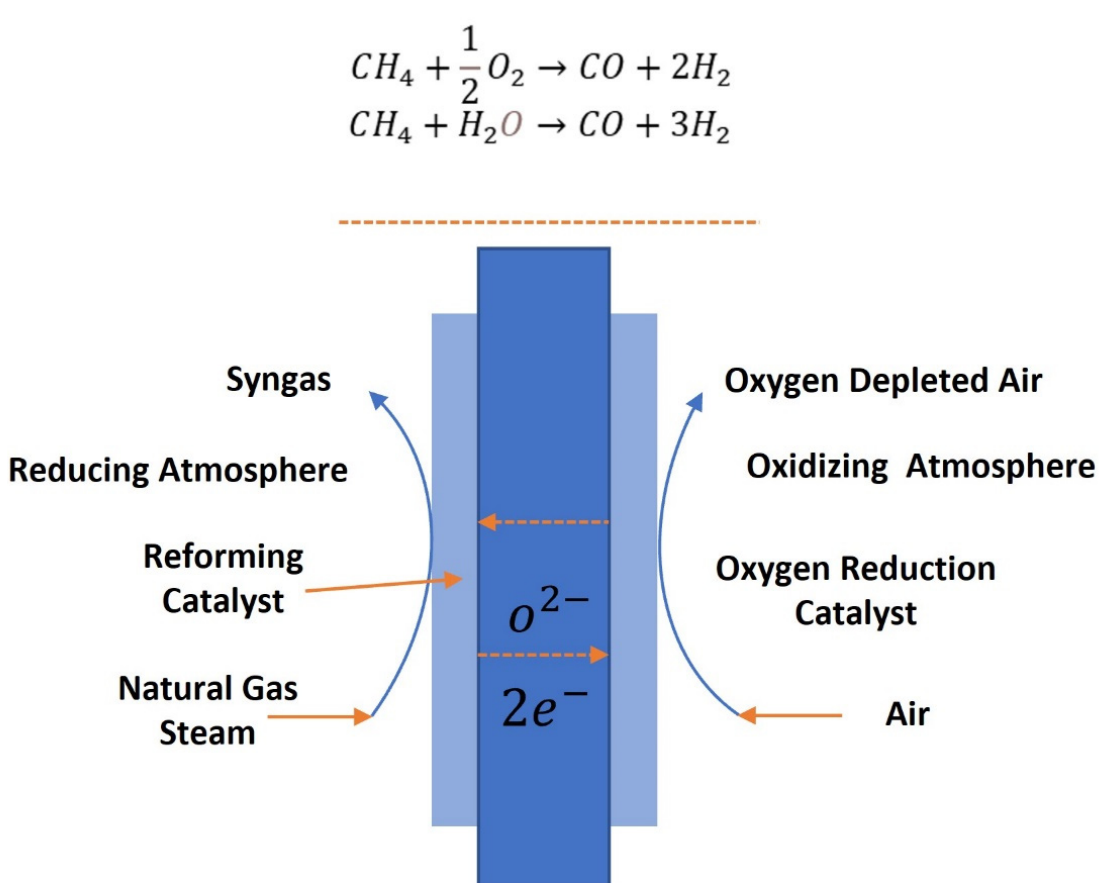
Figure 3. An oxygen transport mechanism across perovskite ceramic membrane [3].